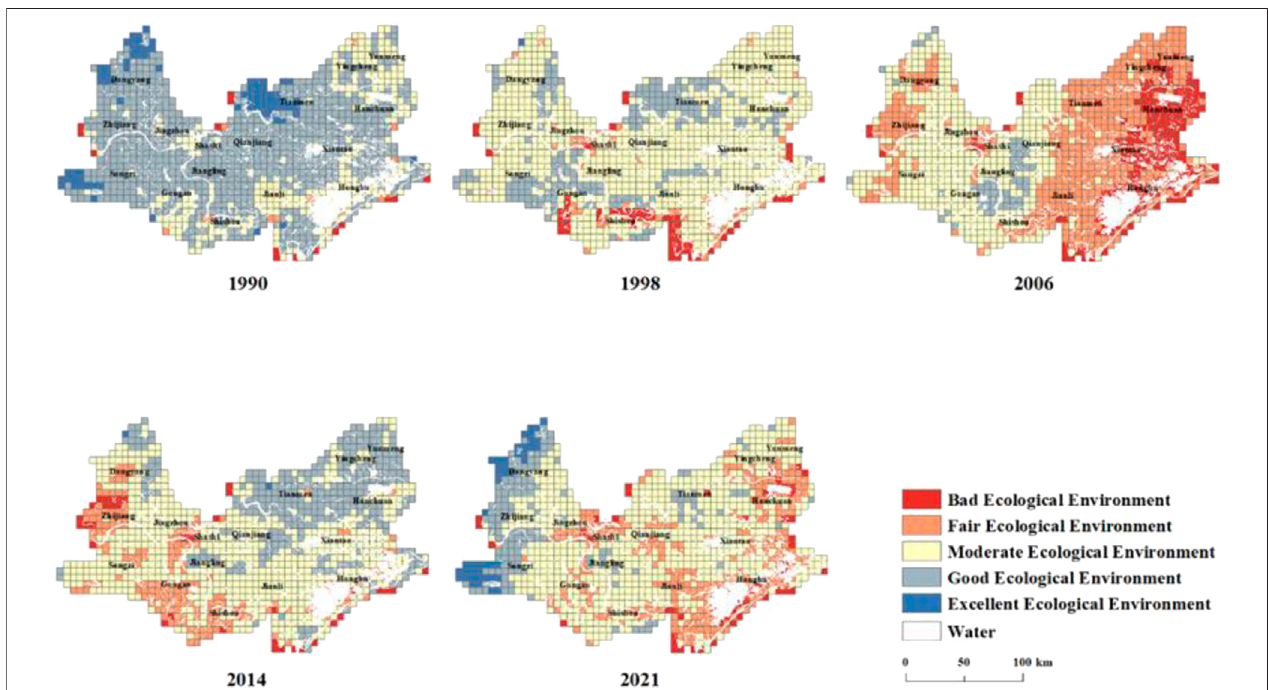
FIGURE 5 | Regional distribution characteristics of eco-environmental quality in Jianghan Plain from 1990 to 2021.